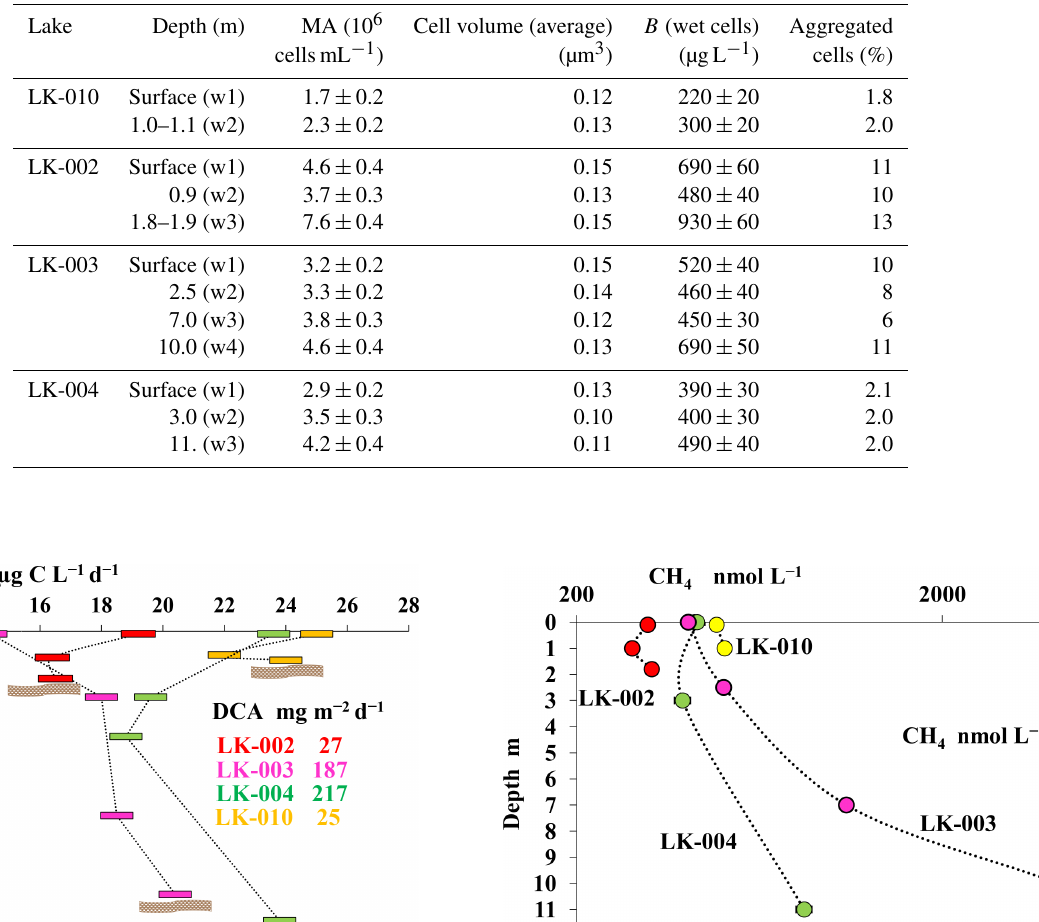
Figure 3. DOC concentration in the water column (a) and pore-water of bottom sediments (b) of four lakes. Location of the bottom is indicated by a brown wavy band. Table 2. Microbial abundance (MA), cell volume, and biomass ( B ) in the water column of the studied Yamal lakes.